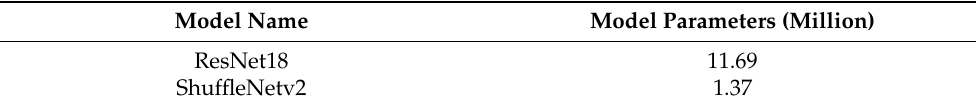
Table 1. Comparison of ResNet18 network and ShuffleNetv2 network parameters.